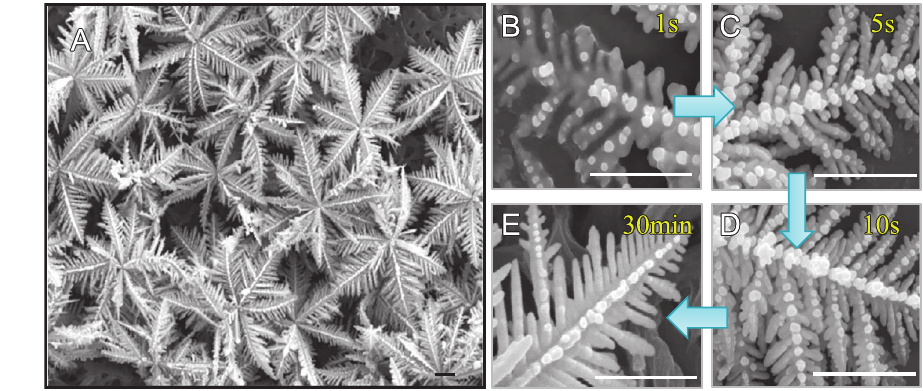
Fig. 3 SEM images of the silver dendrites synthesized in water at different reaction time. A showing the low-magnification SEM image of silver dendrites synthesized after 30 min, indicating high yield and uniform of product; B–E showing silver dendrites synthesized in 1 s, 5 s, 10 s, 30 min, respectively. The scale bars represent 1